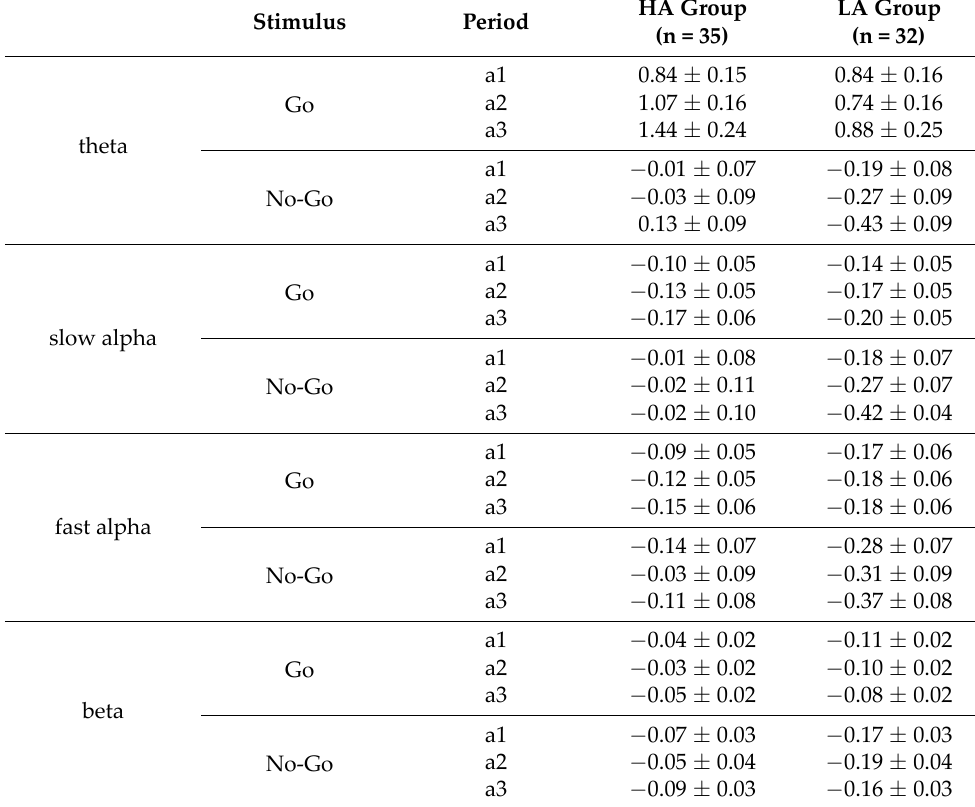
Table 6. Mean ERSP values for delta, slow alpha, fast alpha, and beta frequency bands (dB) (460–700 ms) (M ±